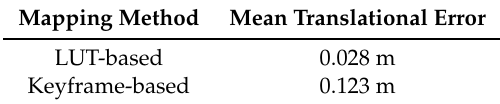
Figure 9. Translational error on the TUM dataset. Table 4. Average translational error on the TUM dataset.